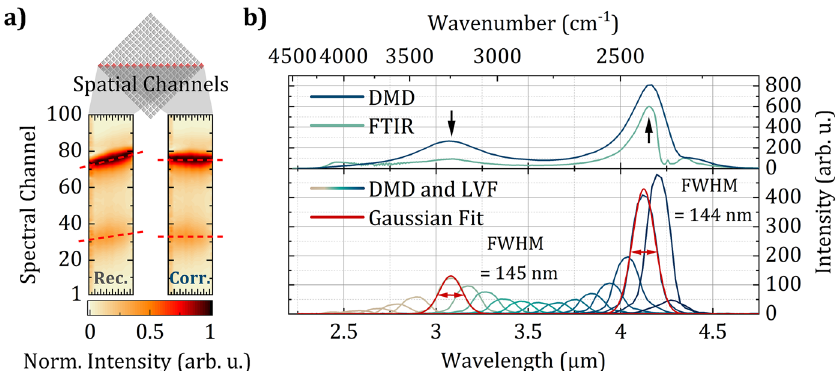
Figure 3. Spectral resolution of the MIR hyperspectral SPI microscope ( a ) False color images of 16 normalized spectra of the spatial channels along the horizontal DMD diagonal (indicated in the mirror matrix on top) resulting from block averaging 64 × 64 images of a USAF resolution test target along the vertical diagonal. Before (left) and after (right) correction of the spectral gradient, respectively. ( b ) Comparison of the SCL emission spectrum recorded with the developed microscope and an FTIR spectrometer used for wavelength calibration (top). Transmission through a LVF at different positions and Gaussian fits to estimate the spectral resolution of the developed instrument